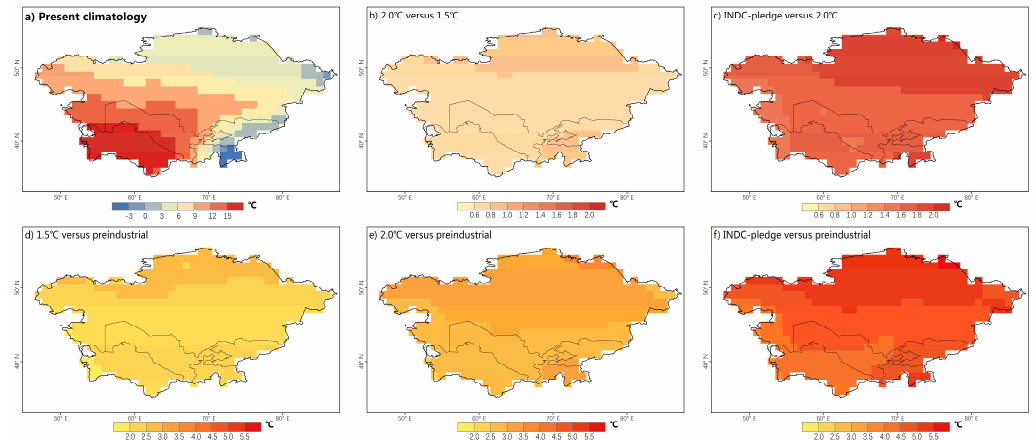
Figure 2. ( a ) Present annual mean temperature over Central Asia; ( b–f ) Changes in the annual mean temperature over Central Asia. The differences between different sets of scenarios are displayed in the top-left corner (based on the multi-model ensemble mean).